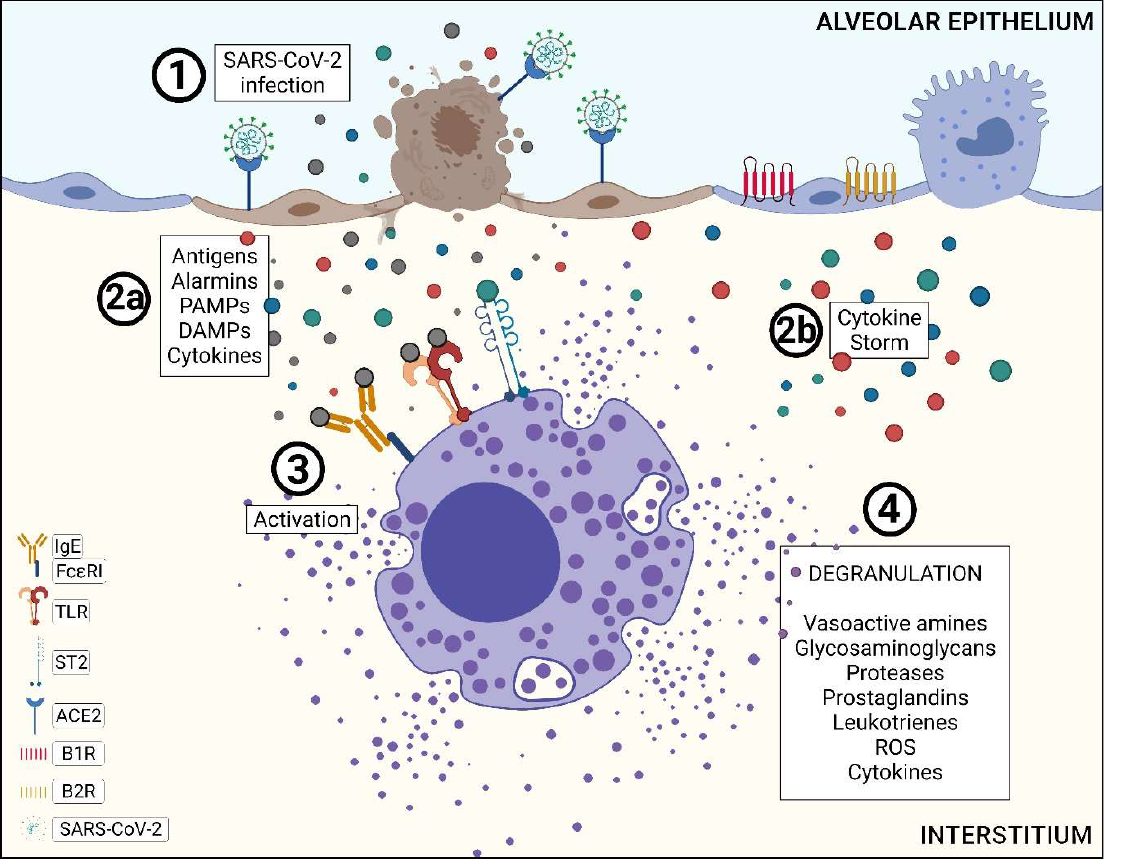
Figure 3. Pathophysiology of SARS-CoV-2 infection in the lower airways and mast cell activation. (1) With the arrival of SARS-CoV-2 in the alveolar environment, it starts to infect type-I and -II pneumocytes, which express ACE2 in their plasma membrane. ACE2 has an affinity with the viral S-Spike protein, used to enter the host cell. (2a) The infectious process causes pneumocytes to die by various means, especially pyroptosis, and this is mainly mediated by CASP-1. The death process by pyroptosis leads to the secretion of antigens, alarmins, PAMPs, DAMPs and cytokines. IL-33, which has the ST2 receptor, acts as an alarmin and is secreted by cells affected by inflammatory insults, present in the infectious processes caused by SARS-CoV-2. (2b) This significant cytokine secretion contributes to the cytokine storm. (3) A large amount of pyroptotic elements triggers the recruitment and activation of alveolar interstitium-resident mast cells (MCs) through the binding of antigens and alarmins with several sensitive receptors present in their plasma membranes. Fc epsilon RI (FcεRI) has an affinity for IgE sensitized by antigens, and toll-like receptors (TLRs) also have an affinity for antigens and alarmins. (4) As a result of activation, MCs secrete many classes of chemical mediators that act on inflammatory processes. Examples are vasoactive amines, glycosaminoglycans, proteases, lipid mediators, reactive oxygen species (ROS) and a large class of cytokines, which play an essential role in inflammatory events and in the recruitment of other inflammatory